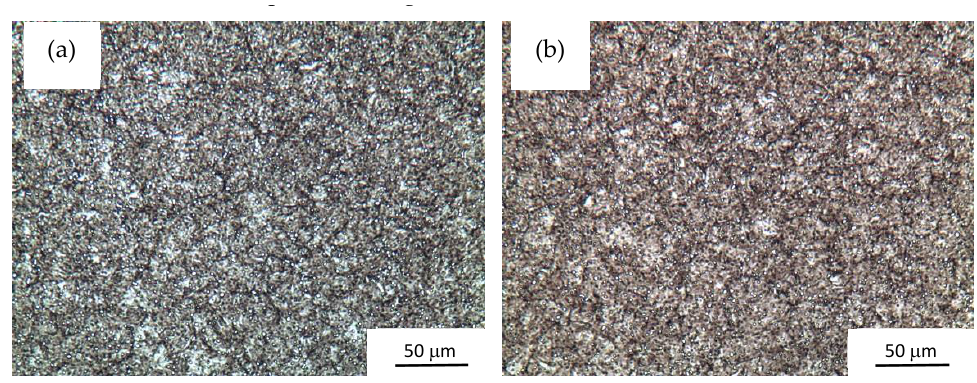
Figure 3. Optical micrographs of K890 Microclean steel after: ( a ) conventional K890-I and ( b ) K890-II heat treatment.